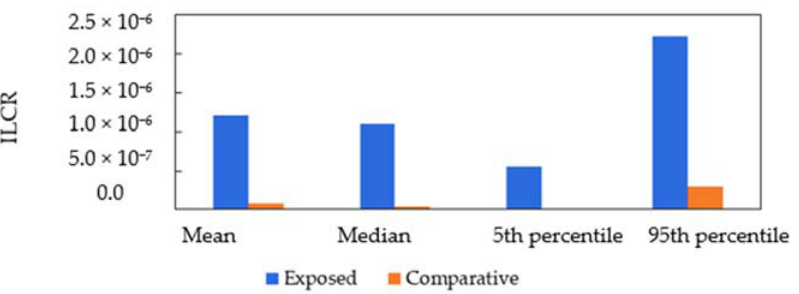
Figure 3. Probabilistic distribution of incremental lifetime cancer risk (ILCR) for exposed and comparative children.